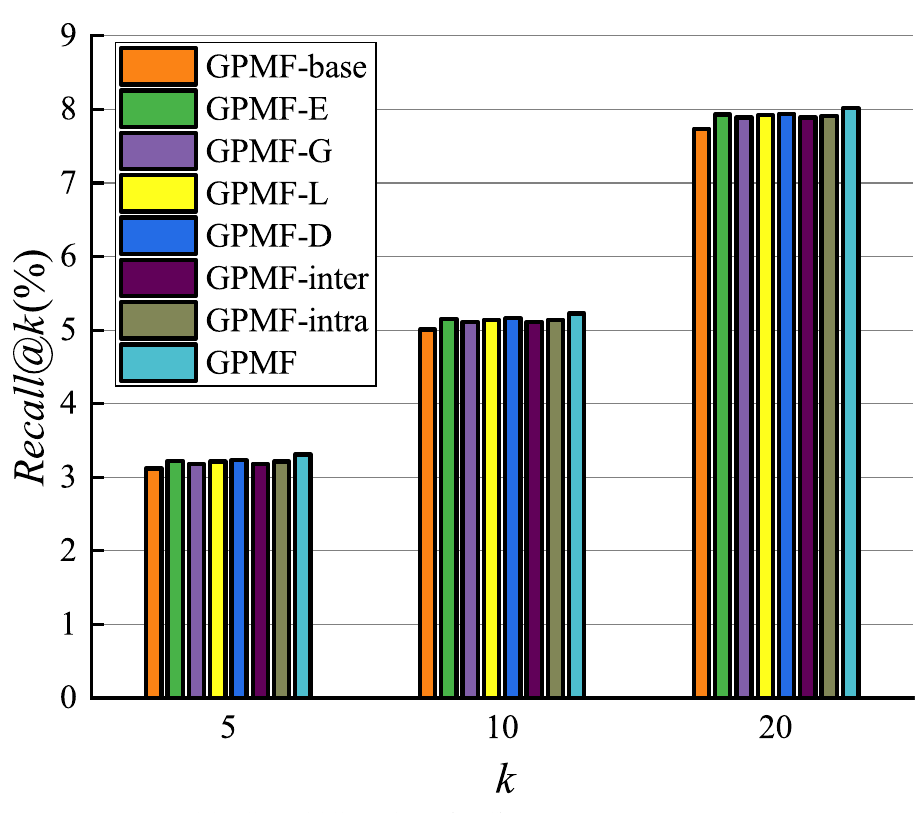
Fig 14. Comparison of the effects of different